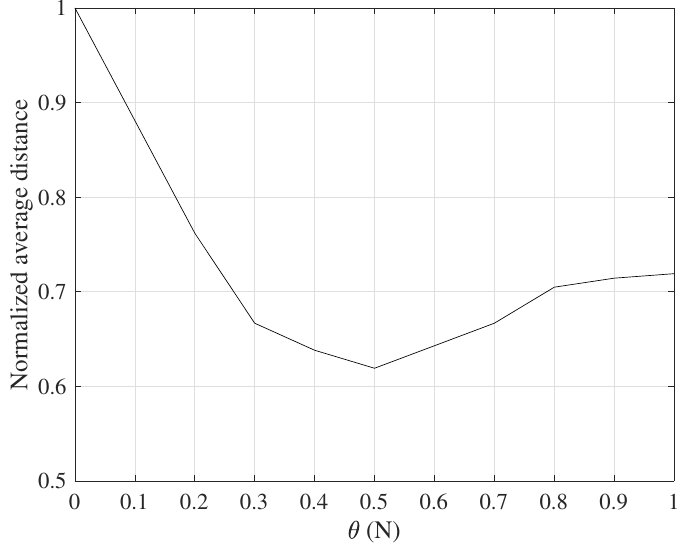
Figure 2. Routing performance with varying offset coefficient θ